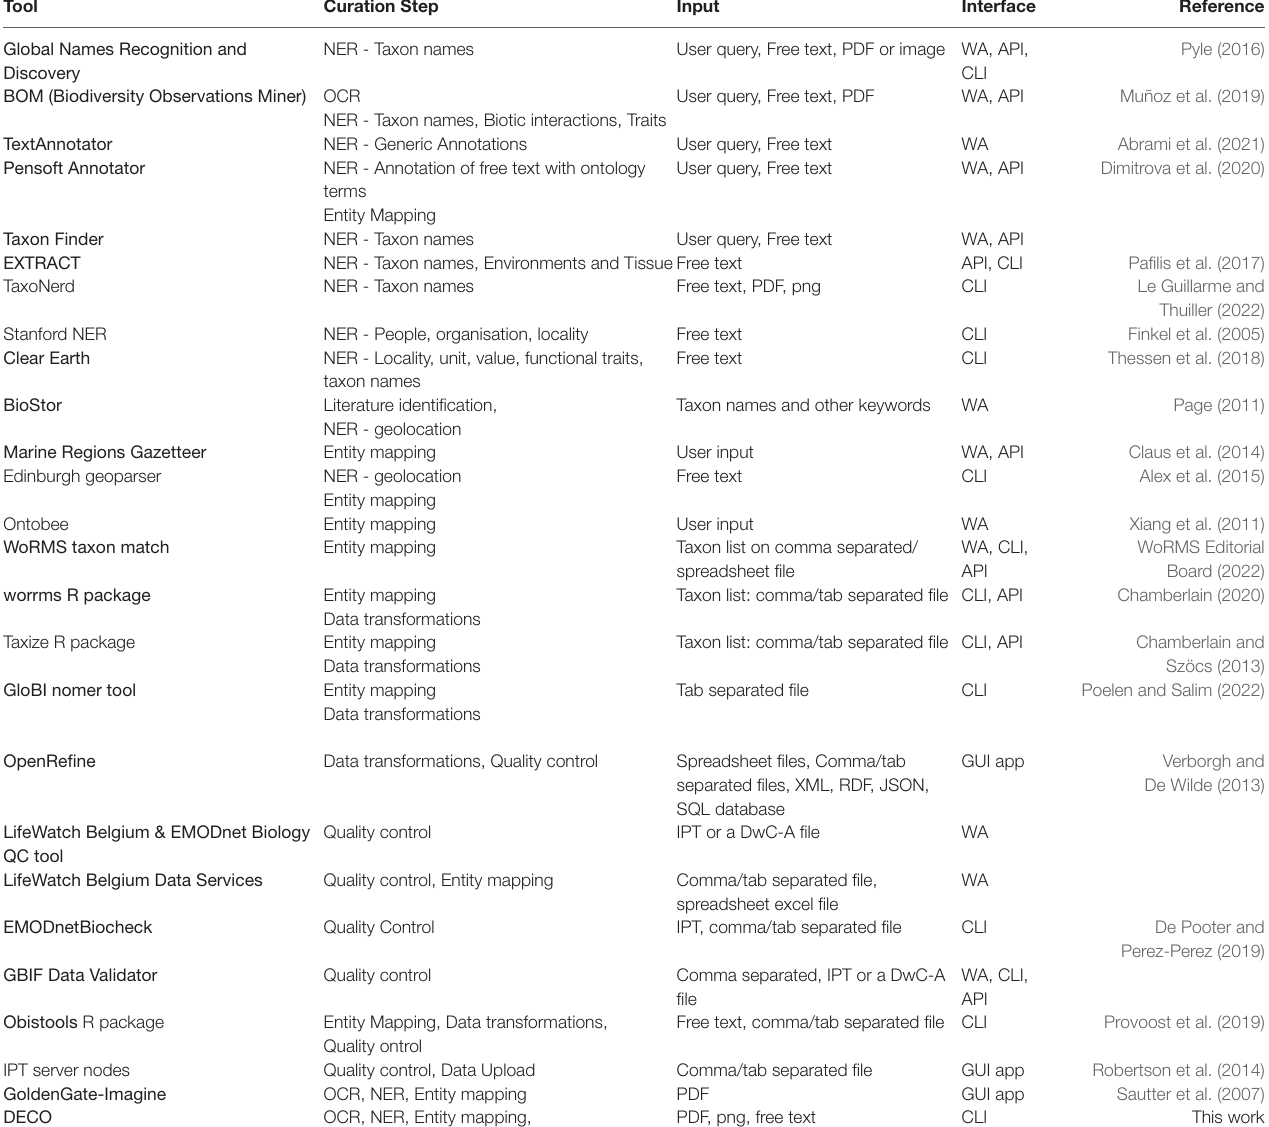
TABLE 1 | Functions, interface and curation step of the tools tested in this work.